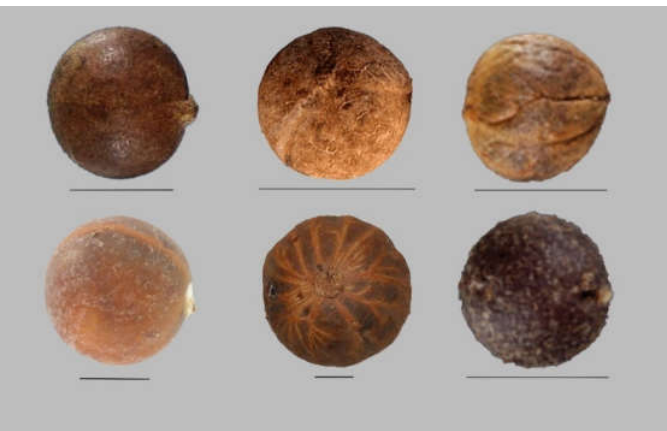
Figure 4. Representative examples of round seeds ( J index values are indicated between parentheses). From left to right: Acoelorrhaphe wrightii (93.6), Acrocomia aculeata (95.7), Coccothrinax argentata (92.6), Geonoma congesta (96.1), Iriartea deltoideia (95.3), and Thrinax radiata (95.4). The seed of Iriartea deltoidea is oriented with the attachment of the peduncle in a frontal position. In the other seeds, the place of attachment of the peduncle is in a lateral position. Bars represent 0.5 cm.